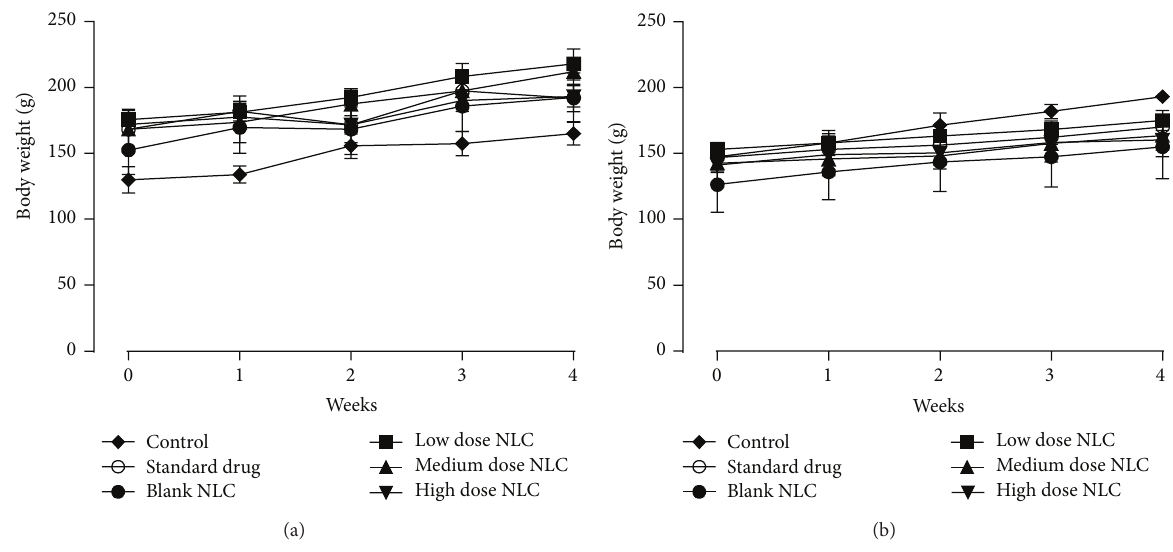
Figure 1: Change in body weight of (a) male rats and (b) female rats treated with NLCs formulation. All the values are represented as mean ± SEM and 𝑛 = 5